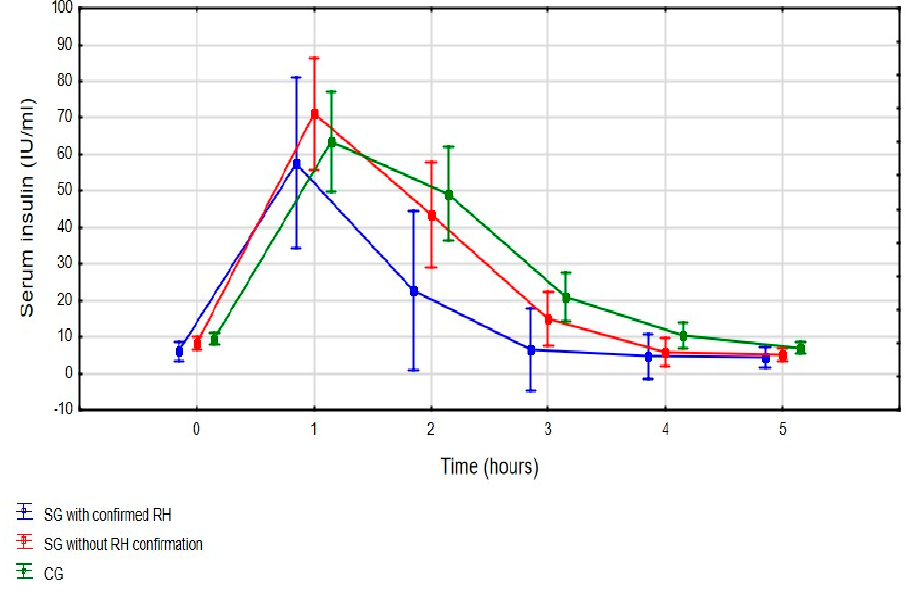
Figure 3. Mean insulin values during 5-h OGTT (three-way ANOVA: F (10, 360) = 1.290, p = 0.234) [mean insulin value with a 95% confidence interval]. SG—Study Group; CG—Control Group; RH—Reactive Hypoglycemia.